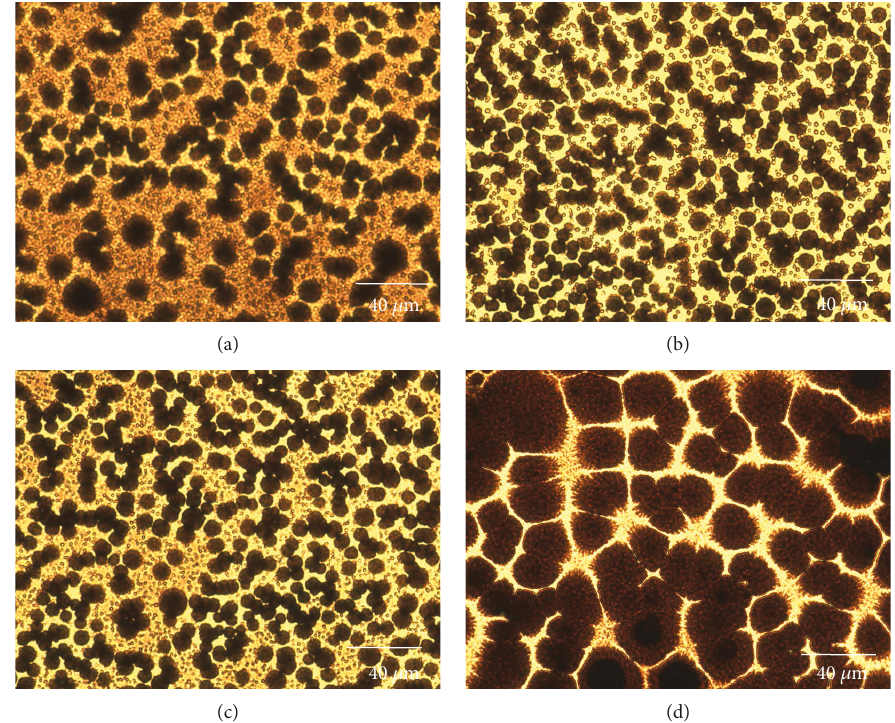
Figure 4: Optical microscopy images of (a) CH